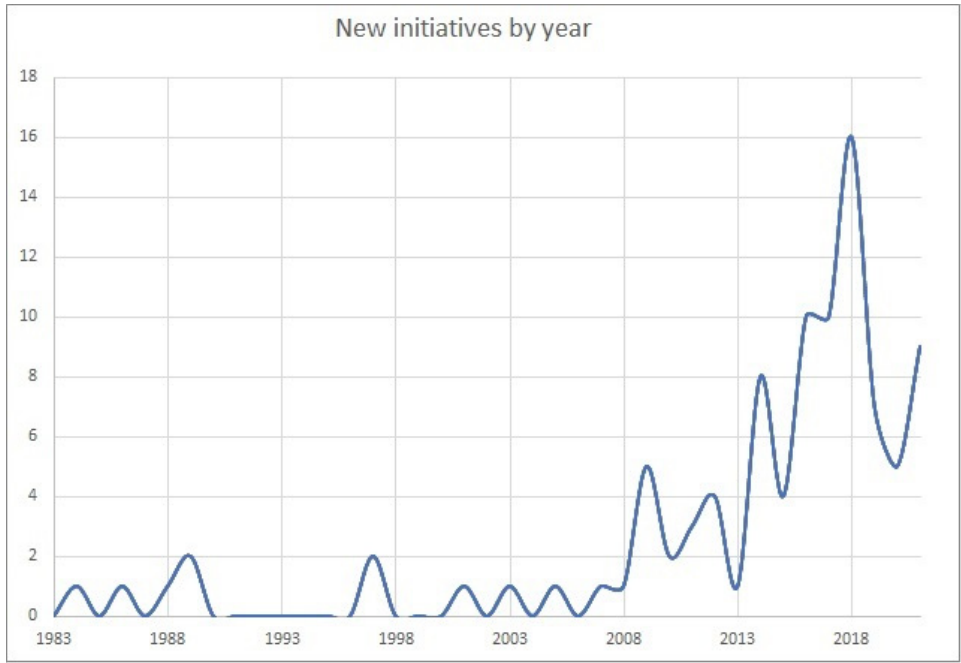
Figure 2. Initiative organization type.